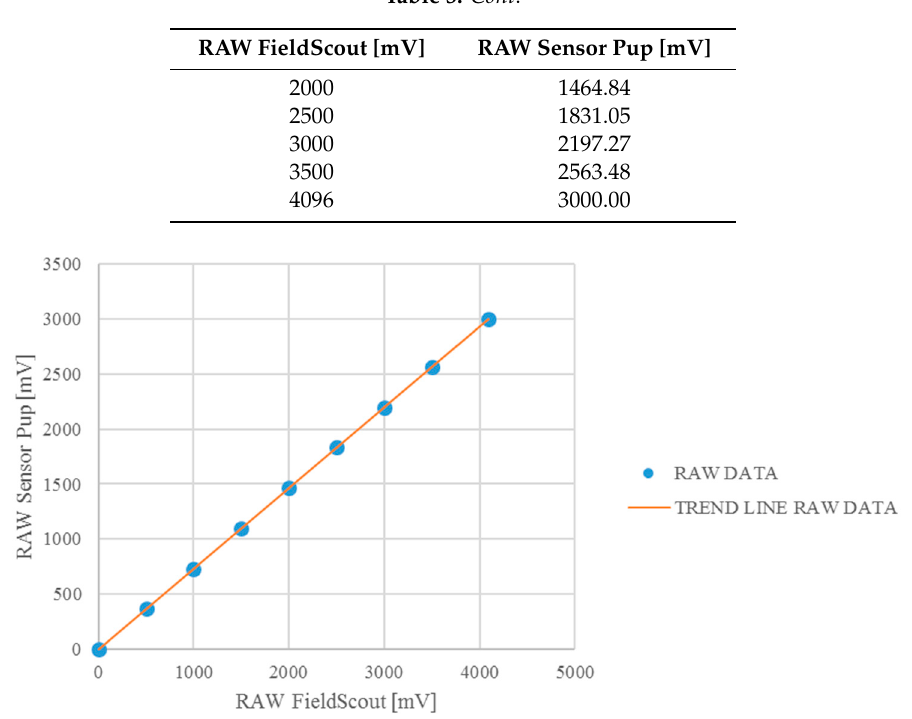
Figure 15. Relationship between FieldScout Soil Sensor Reader and Sensor Pup raw data.